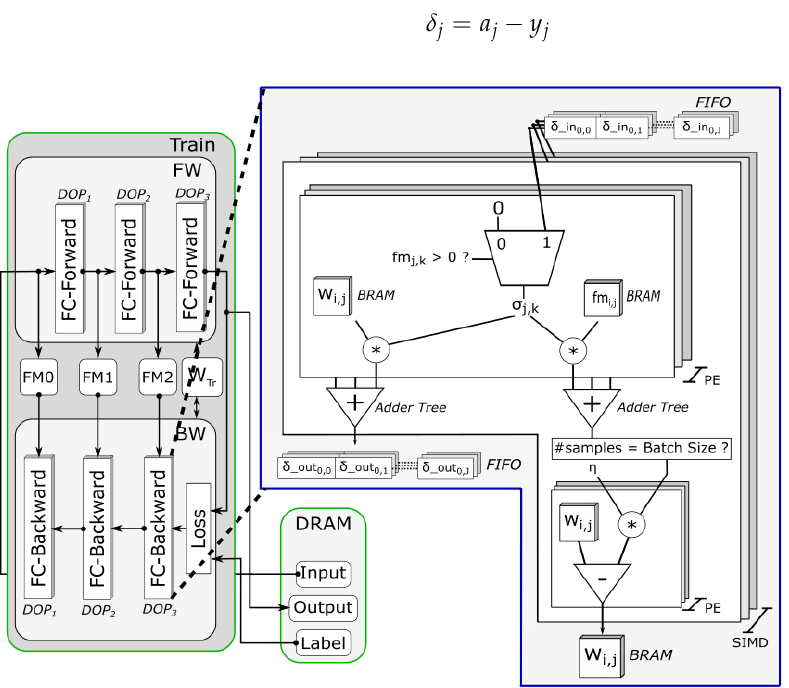
Figure 6. FPGA design of the training